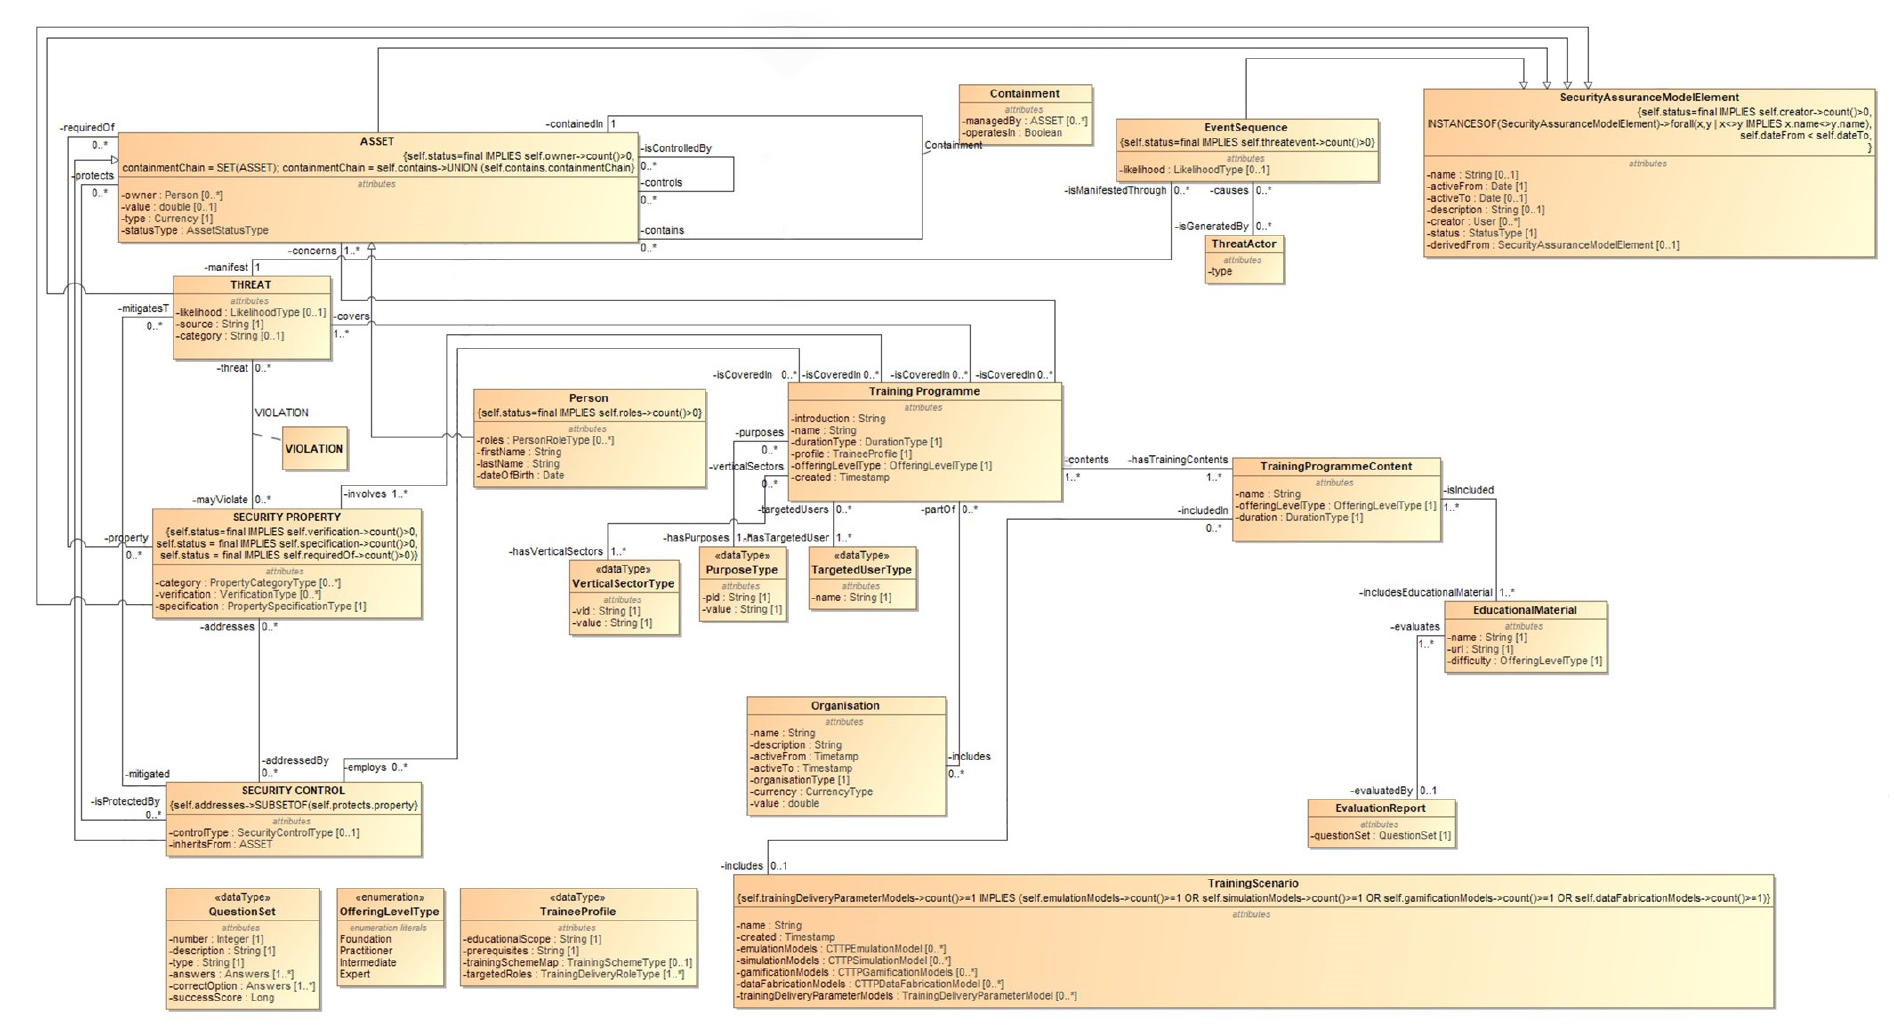
Figure 3. CYRA’s UML